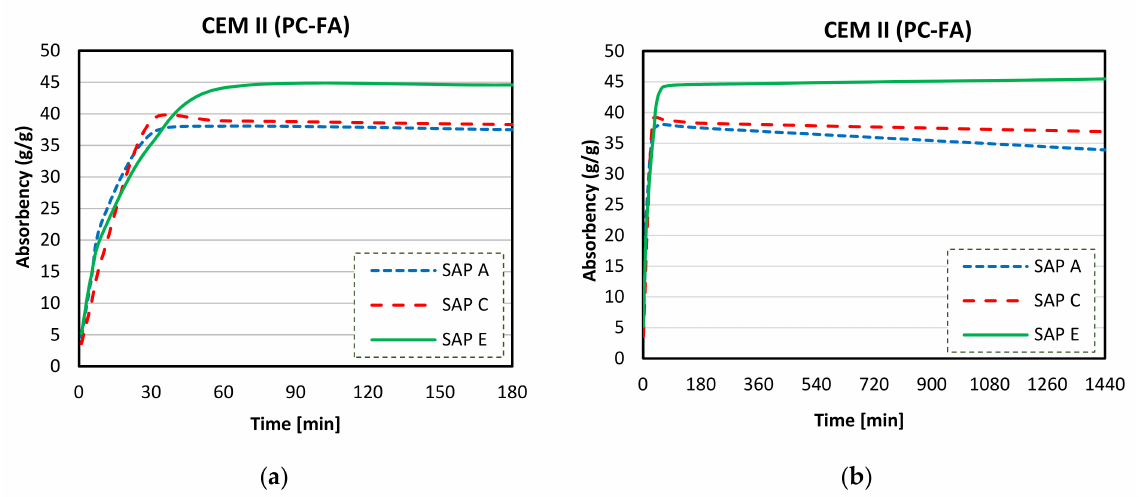
Figure 14. Sorption behaviour of SAPs in CEM II (PC-FA) up to 180 min ( a ) and up to 1440 min ( b ). Figure 15a,b illustrate absorption curves of SAPs in CEM III (PC-GGBS) solution. Similar behaviour (to CEM I) of SAP absorption was recorded again: SAP E had the ability to maintain most of the initial max WAC, while the WAC of SAP A was